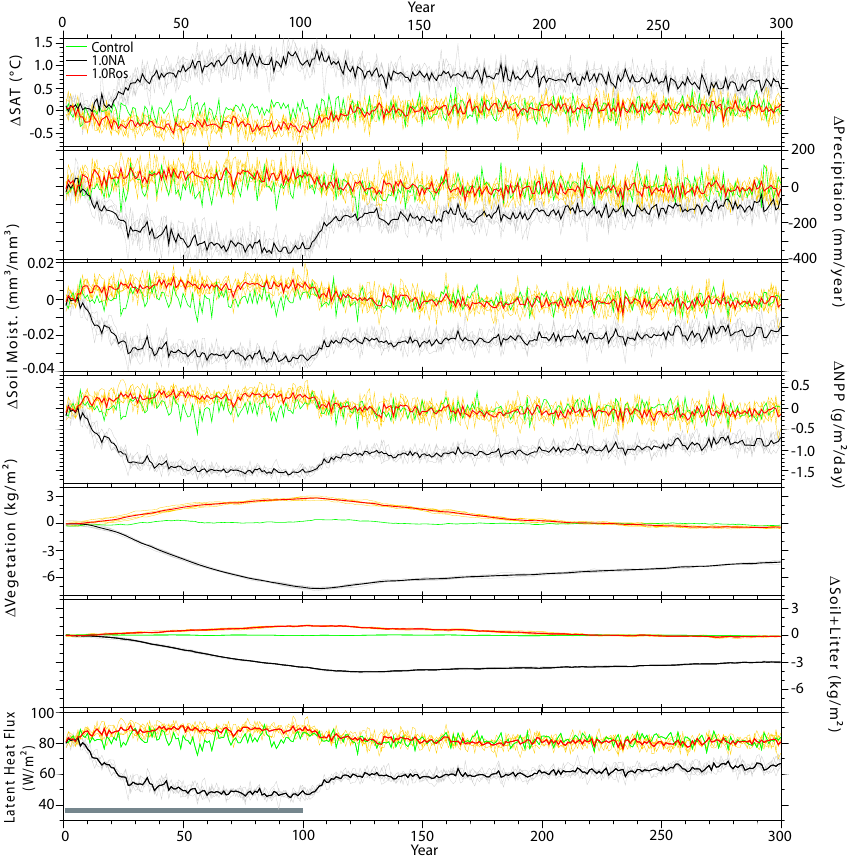
Fig. 9. Time evolution of the changes in the northern part of South America (the region marked in Fig. 8, top left panel). From top to bottom are shown the anomalies in SAT ( ◦ C), precipitation (mmyr − 1 ), soil moisture (mm 3 mm − 3 ), NPP (gm 2 day − 1 ), Vegetation Carbon (kgm − 2 ), Soil and Litter Carbon (kgm − 2 ), and Latent Heat Flux (Wm − 2 ). The green curve is the Control and the black and red curves are the ensemble averages of the 1.0NA the 1.0Ros experiments, respectively. The thin grey and orange curves are the individual ensemble members of the respective experiment. The grey bar at the bottom marks the duration of the freshwater